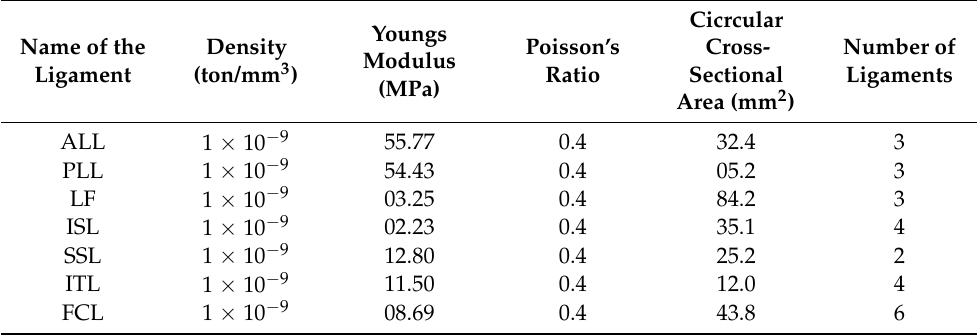
Table 2. Vertebral ligaments material properties used for functional spine unit model in the current finite element study